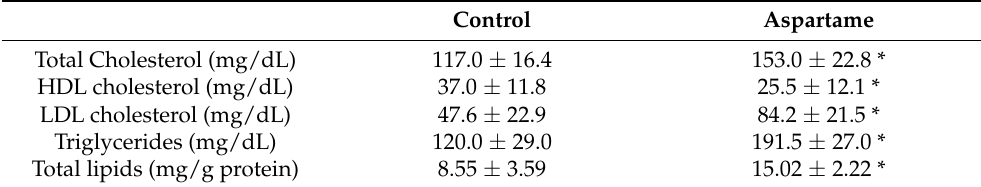
Table 3. Effects of aspartame on fasting lipid profile in serum and total lipids in the mice